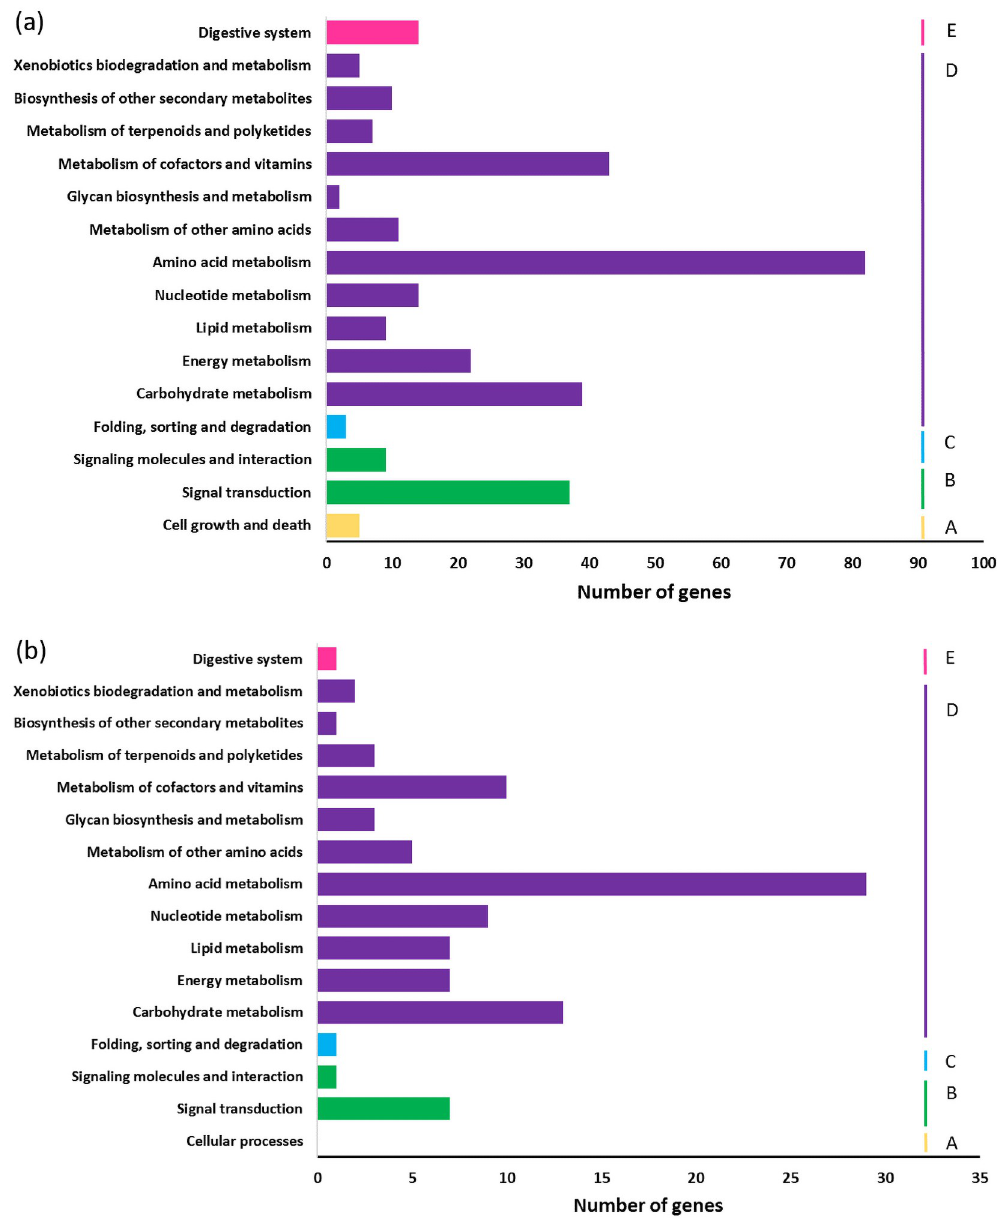
Fig 5. KEGG pathway annotation of DEGs in (a) ‘Bluecrop’ from harvest (BCH) to 24 dph (BC3_3), and (b) ‘Legacy’ from harvest (LGH) to 24 dph (LG3_3). The x-axis shows the number of unigenes annotated and the y-axis details the KEGG pathway category. A) Cellular processes, B) Environmental information processing, C) Genetic information, D) Metabolism and E) Organismal systems. pathways. DEGs were categorized into 61 pathways for ‘Bluecrop’ and into 50 pathways for ‘Legacy’. The categories with containing larger numbers of DEGs annotated were amino acid metabolism, carbohydrate metabolism and metabolism of cofactors and vitamins for both cul- tivars. These pathways were followed by energy metabolism in ‘Bluecrop’ and by nucleotide metabolism in Legacy’ (Fig 5).